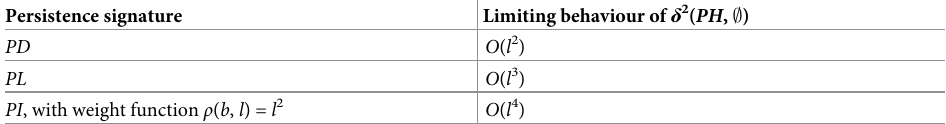
Table 1. Persistent homology across